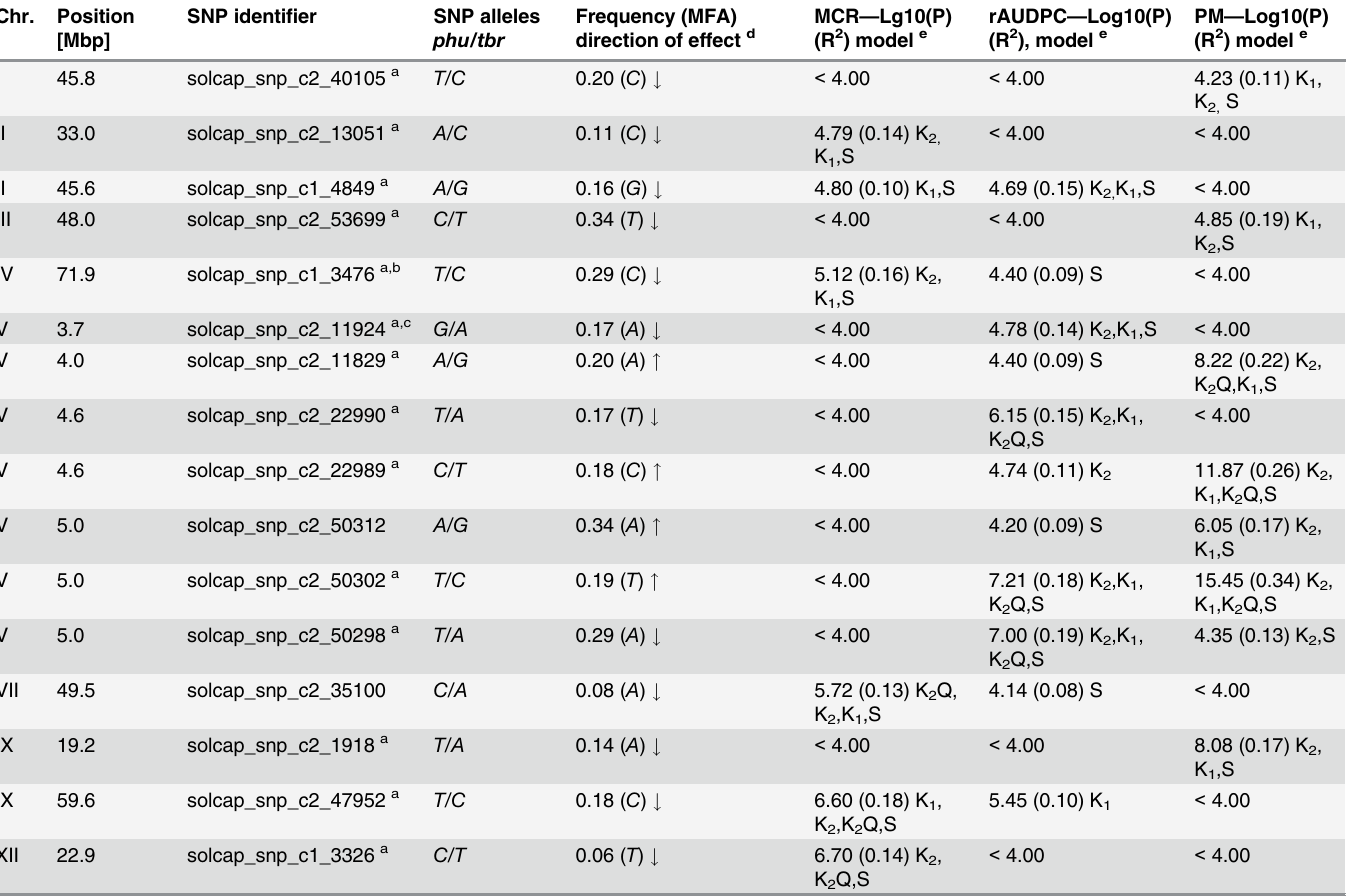
Table 6. SolCAP SNPs associated with MCR, rAUDPC and/or PM in three or four association models (-Log10(P) > 4). Full data are available in S9 – S11 Files. Chr. Position